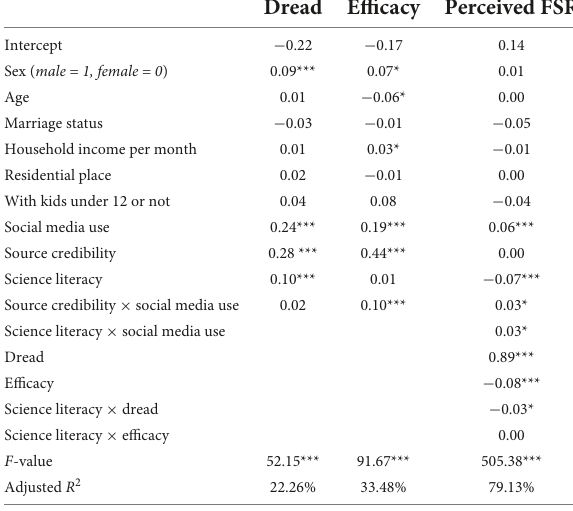
TABLE 3 Moderated mediation regression